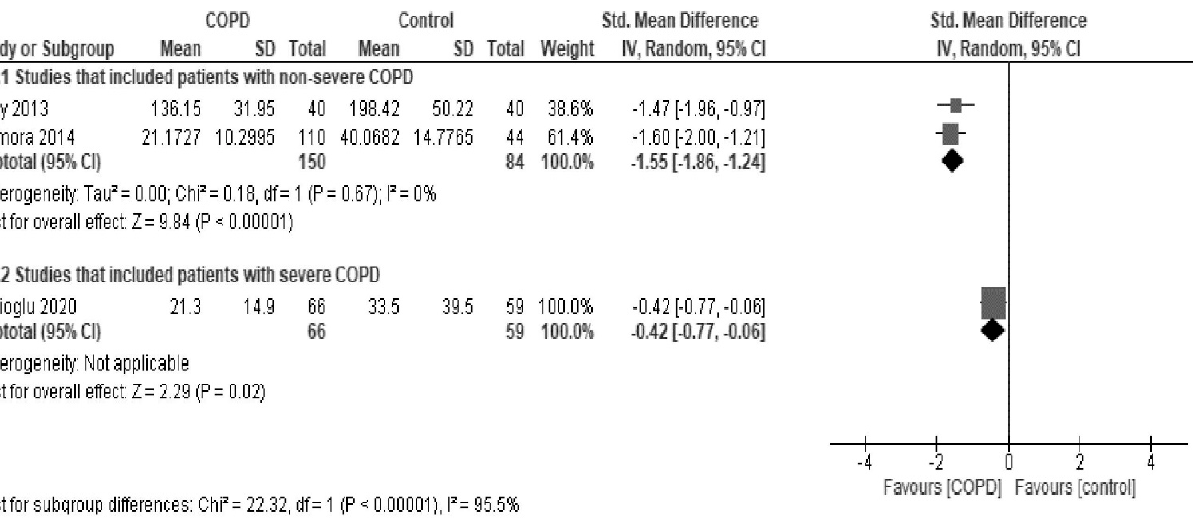
Figure 5. Forest plot of arylesterase activity stratified by the severity of COPD.